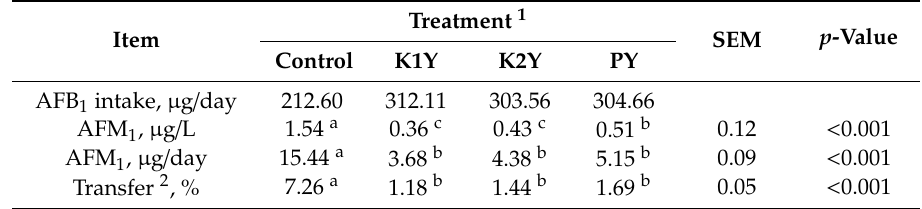
Table 2. Aflatoxin B 1 (AFB 1 ) dairy intake and least-squares means of concentration of aflatoxin M 1 (AFM 1 ) and carryover in cows fed TMR supplemented with aflatoxins-detoxifying yeast. Treatment 1 Item